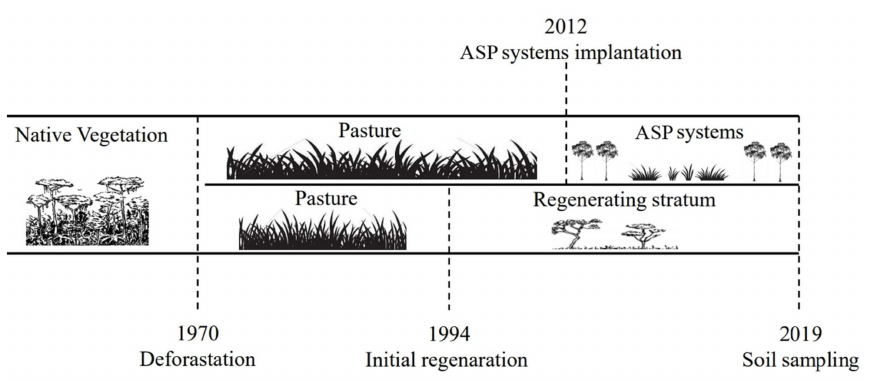
Figure 2. Schematic representation of the land use history at Bonsucesso farm in Minas Gerais State,